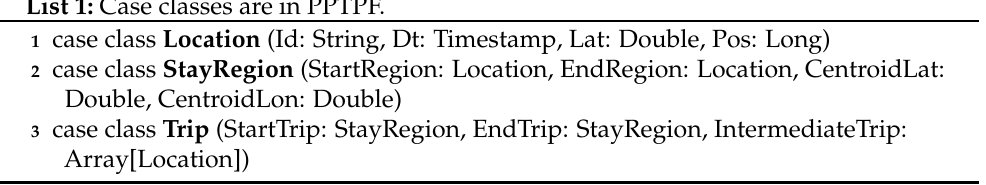
Algorithm 1: Sorting Component in